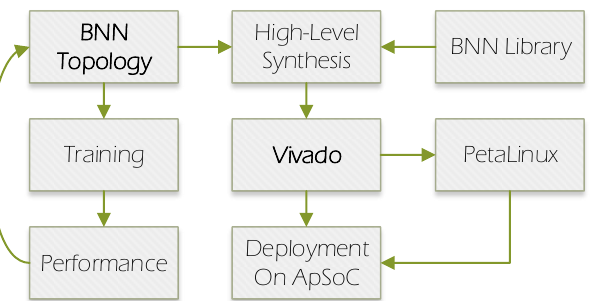
Figure 1. Flow chart illustrates the approach of our BNN development which involves procedures of training and